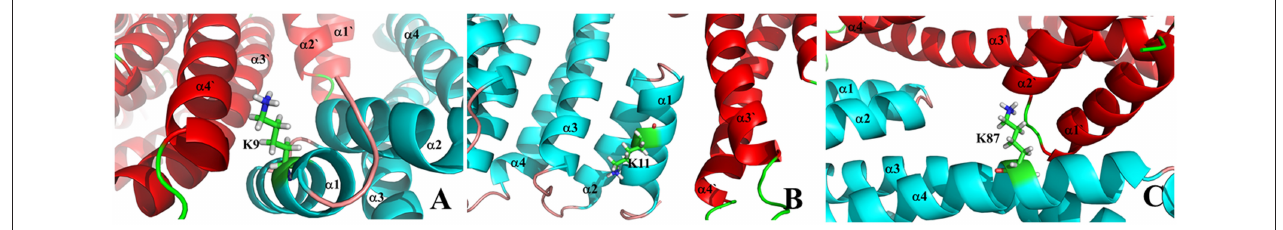
FIGURE 6 | The zoom-in view for I-type lysine residues on the dimer interface of 14-3-3 σ dimer. (A) K9, (B) K11 and (C) K87.